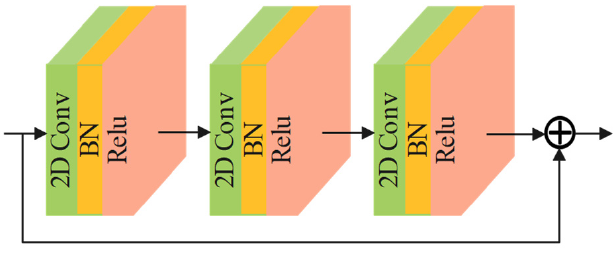
Figure 3. The Structure of Res Block.